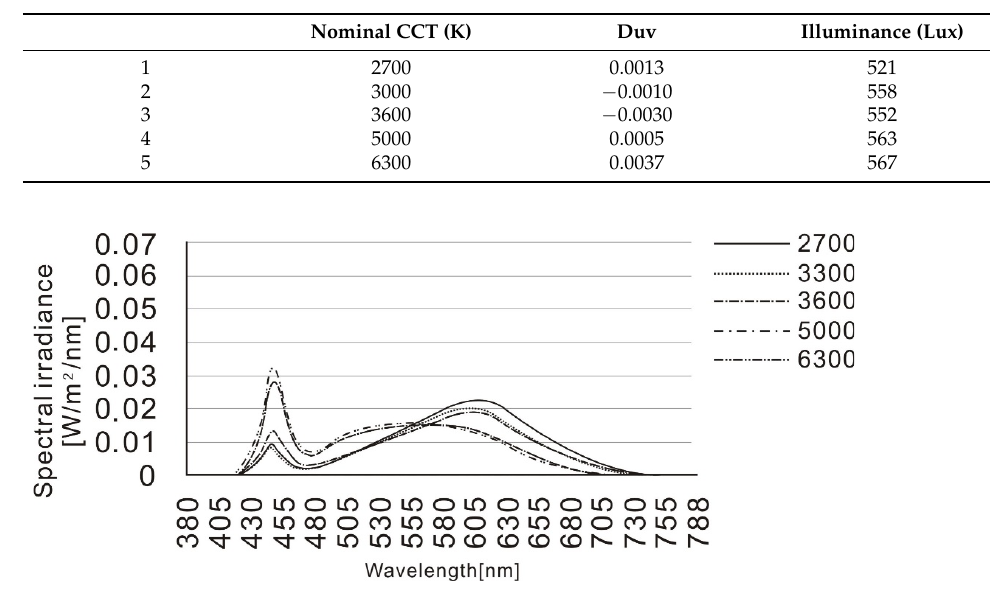
Figure 1. Exterior view of the hygiene area and drawings of the simulator. The experiments were carried out using a simulated lighting system (LED, supplied by Touslite Lighting System, TLS Lighting, Badersfield, UK) for the hygiene area. All equipment was new and installed one month prior to the official experiment. Table 1 shows the Duv and illuminance for the five lighting conditions. The spectral distributions of the LED lighting at the five different colour temperatures are shown in Figure 2. The illuminance was measured at eye level with a calibrated spectroradiometer (JETI Specbos 1201, JETI Technische Instrumente GmbH, Jena, Germany) and the luminaire was switched on for 30 min before each session to stabilise the illuminance. The walls and ceiling were off ‐ white with 72% and 67% reflectance, respectively. The light grey floor had a reflectance of 31% and the off ‐ white operating panel had a reflectance of 66%. The lumi ‐ nance images were captured using a TechnoTeam LMK Mobile (TechnoTeam, Ilmenau, Germany) prior to the experiments, which captured a fairly even distribution of lumi ‐ nance at the floor and wall locations, between approximately 250–300 cd/m 2 on the floor and between 125 and 250 cd/m 2 on the walls. The lighting system was mounted on the ceiling and was clearly visible to the participants, although their main field of vision was the operating panel in front of them. Table 1. Duv and illuminance measured at desk level for each nominal CCT after the lighting ani ‐ mations had been set up.